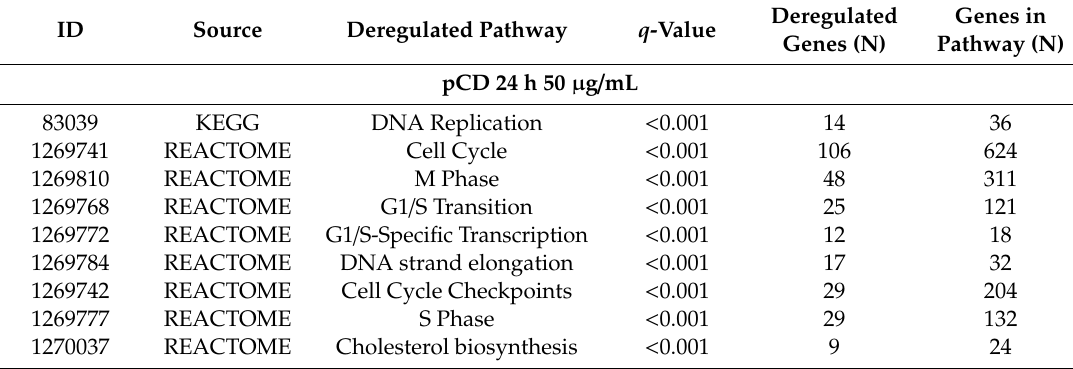
Table 1. Selected pathways deregulated after pCD NPs exposure.